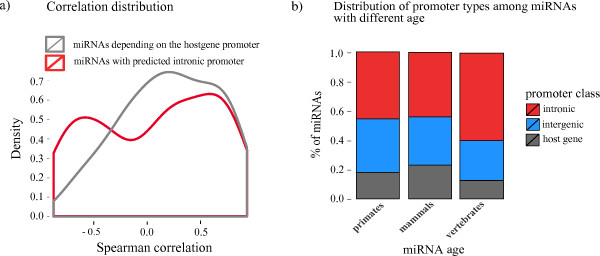
Role of intronic promoters. (a) Distribution of Spearman's correlation coefficient between the expression profiles of intragenic miRNAs and their corresponding host genes in the human brain. The gray probability density function (PDF) is for those intragenic miRNAs that are predicted to have an independent intronic promoter in the FANTOM4 brain libraries, while the red PDF is for those miRNAs that are predicted to depend on the promoter of the host gene. (b) Association between miRNA age and presence/absence of an independent promoter. The miRNAs are divided into three age classes according to their conservation in different lineages: vertebrates, mammals and primates. Each bar shows the fraction of intergenic, intronic and host gene promoters in each age class. Old miRNAs (conserved in vertebrates) are enriched in independent intronic promoters compared to the other two classes.miRNA, microRNA; PDF, probability density function.